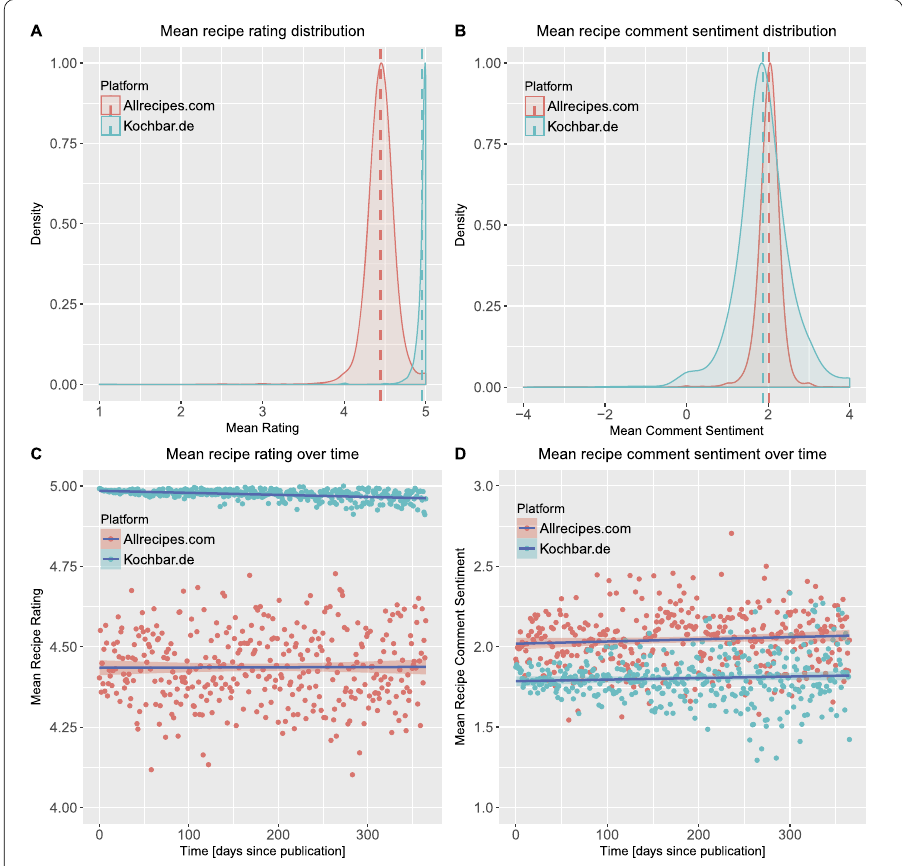
Figure 6 Plots ( A ) and ( B ) present distributions of comment sentiment and ratings in both datasets for recipes (all categories). As presented, in both datasets the ratings applied to recipes are extremely positive ( M = 4.96 (Allrecipes.com) vs M = 4.45 (Kochbar.de)). Similar trends can be observed for the comment sentiment which is also very on the positive (M=2.02 (Allrecipes.com) vs M=1.87 (Kochbar.de), Scale: –4 = very negative to +4 = very positive). Plots ( C ) and ( D ) present mean rating and comment sentiment of recipes over time. The lines represent the linear regression of the observations and the lighter colored hulls show the confidence interval of the regression. As presented on average the trends are rather constant and there are neither strong up or downwards trends